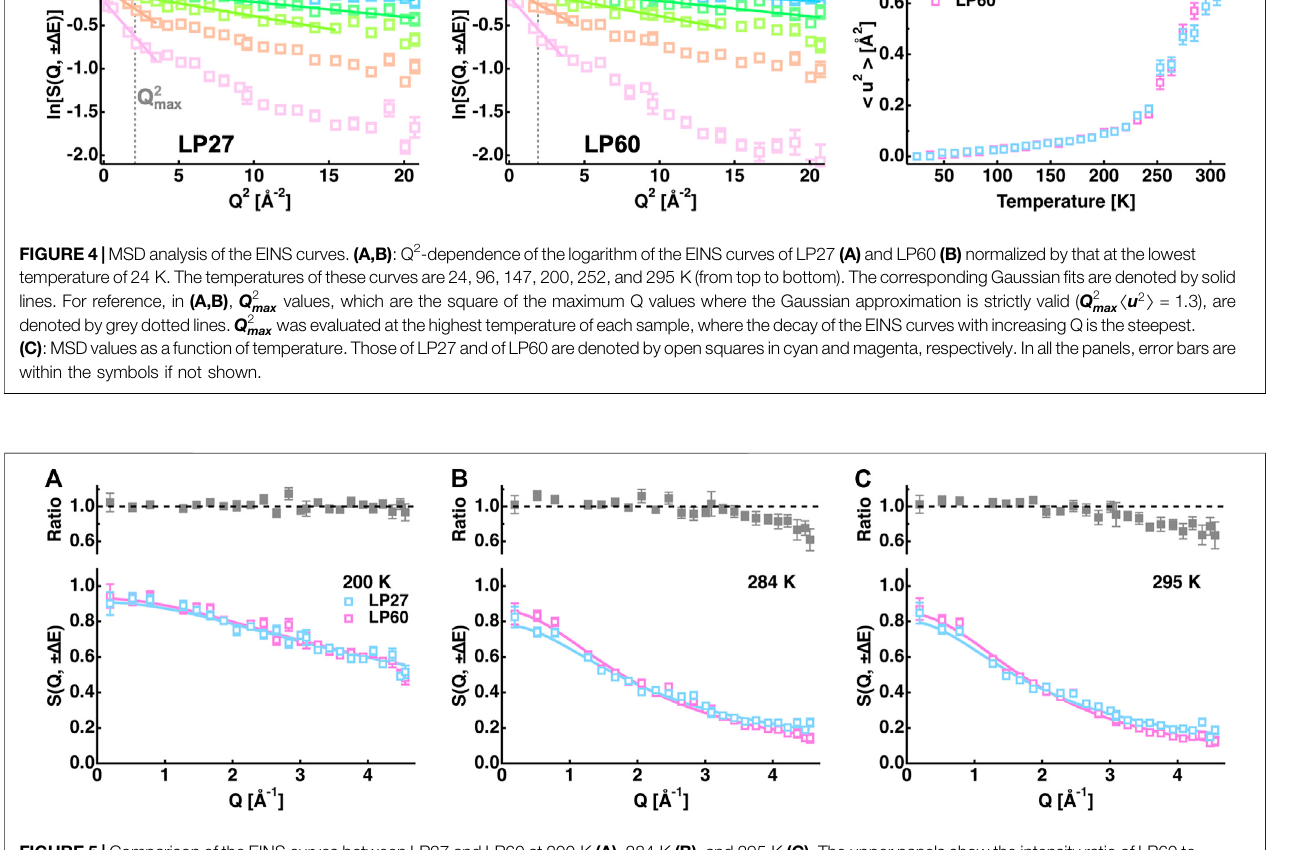
FIGURE5 | Comparison ofthe EINS curvesbetweenLP27 and LP60 at 200 K (A) , 284 K (B) , and 295 K (C) . The upper panels show the intensity ratio ofLP60 to LP27. The cyan and magenta open squares denote the experimental data points of LP27 and LP60, respectively. The solid lines are the corresponding fi ts obtained by Eq. 2 in the main